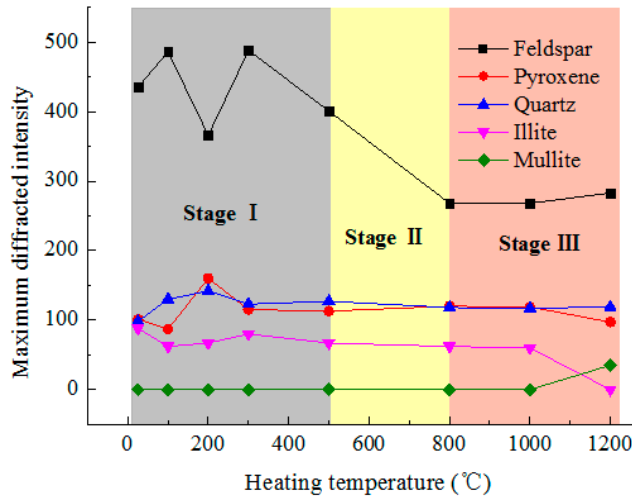
Figure 4. The maximum diffracted intensity (MDI) of the main minerals at different temperatures.